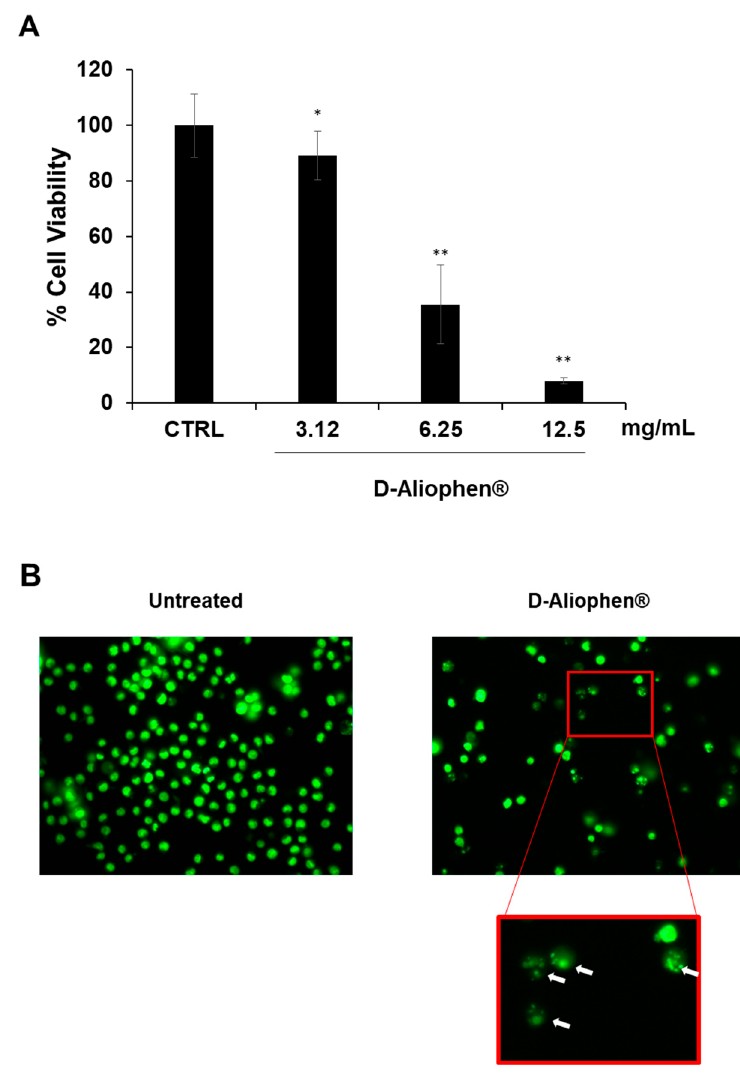
Figure 4. Aliophen ® reduces cell viability in HL-60 cells. ( A ) Cells were treated for 20 h at indi- cated concentration of D-Aliophen ® , and cell viability was assessed using CyQuant as described in Materials and Methods. Bar graphs represent the mean ± SD. Symbols indicate significance vs. untreated cells (CTRL) with * p < 0.05 and ** p < 0.005. ( B ) Representative images of cells untreated (left) and treated for 20 h with 12.5 mg/mL D-Aliophen ® (right) and stained with CyQuant nuclear stain. Cells were visualized using a fluorescent microscopy and photographed in an FITC filter with 400× magnification. The arrows indicate the presence of apoptotic bodies.